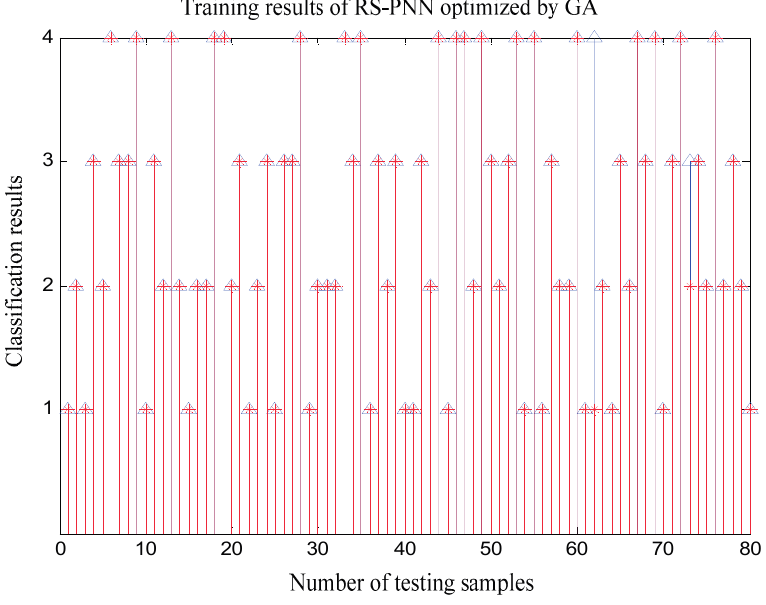
Figure 14. Classification results of RS-PNN optimized by GA under testing